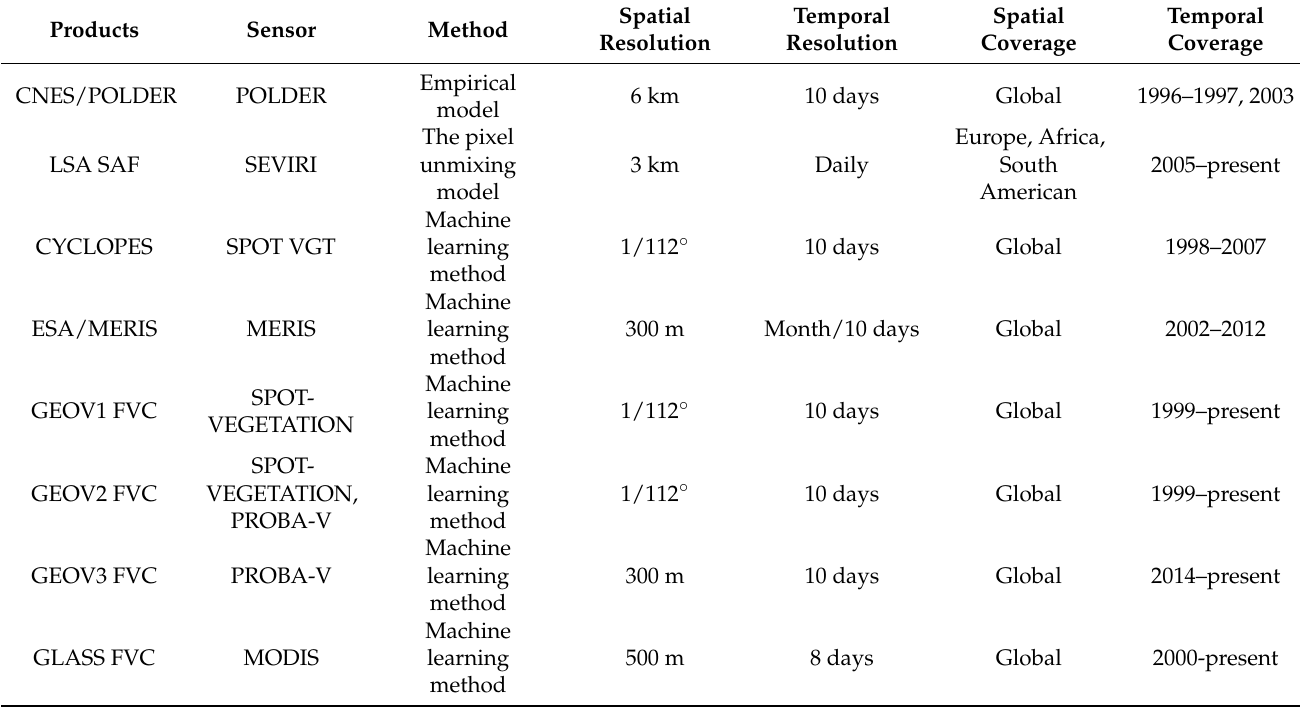
Table 1. Information on the existing FVC products over a large/global scale